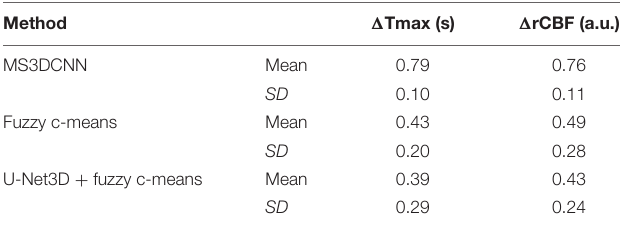
rCBF are both superior to the latter two methods due to the lower time to peak and the larger peak value of the AIF.